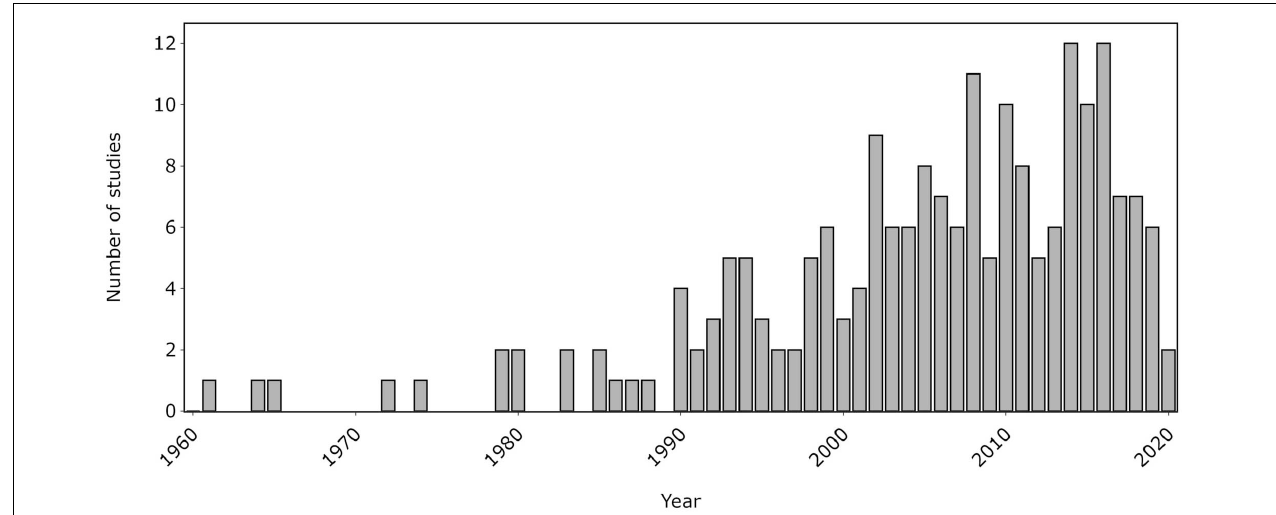
FIGURE 1 | Number of reviewed studies reporting cetacean mixed-species groups from 1961 to 2020.